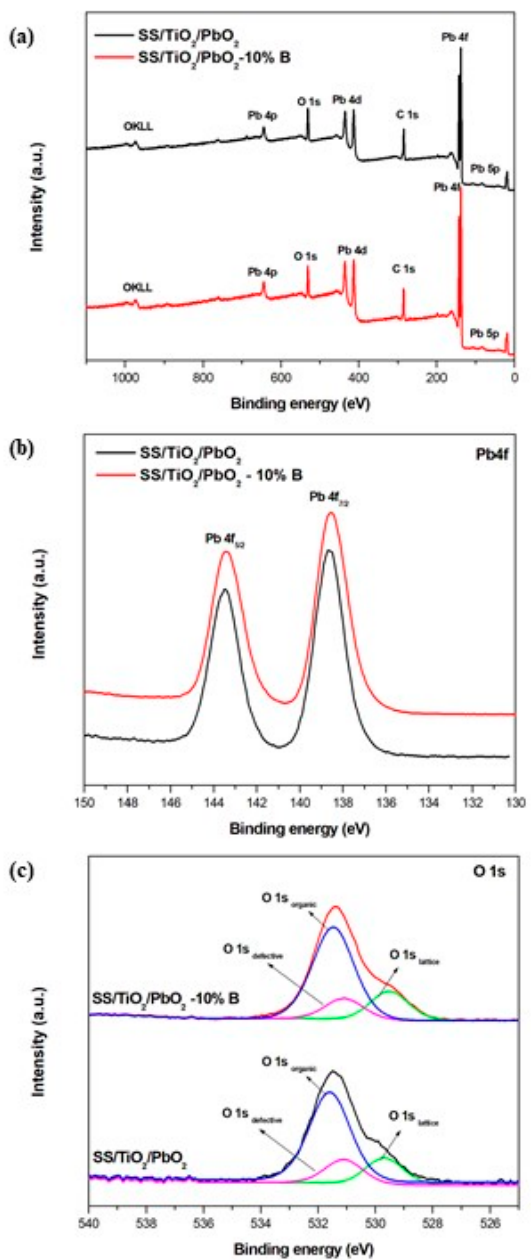
Figure 6. XPS spectrum of SS/TiO 2 /PbO 2 and SS/TiO 2 /PbO 2 -10%B electrodes: ( a ) Wide scan spec-